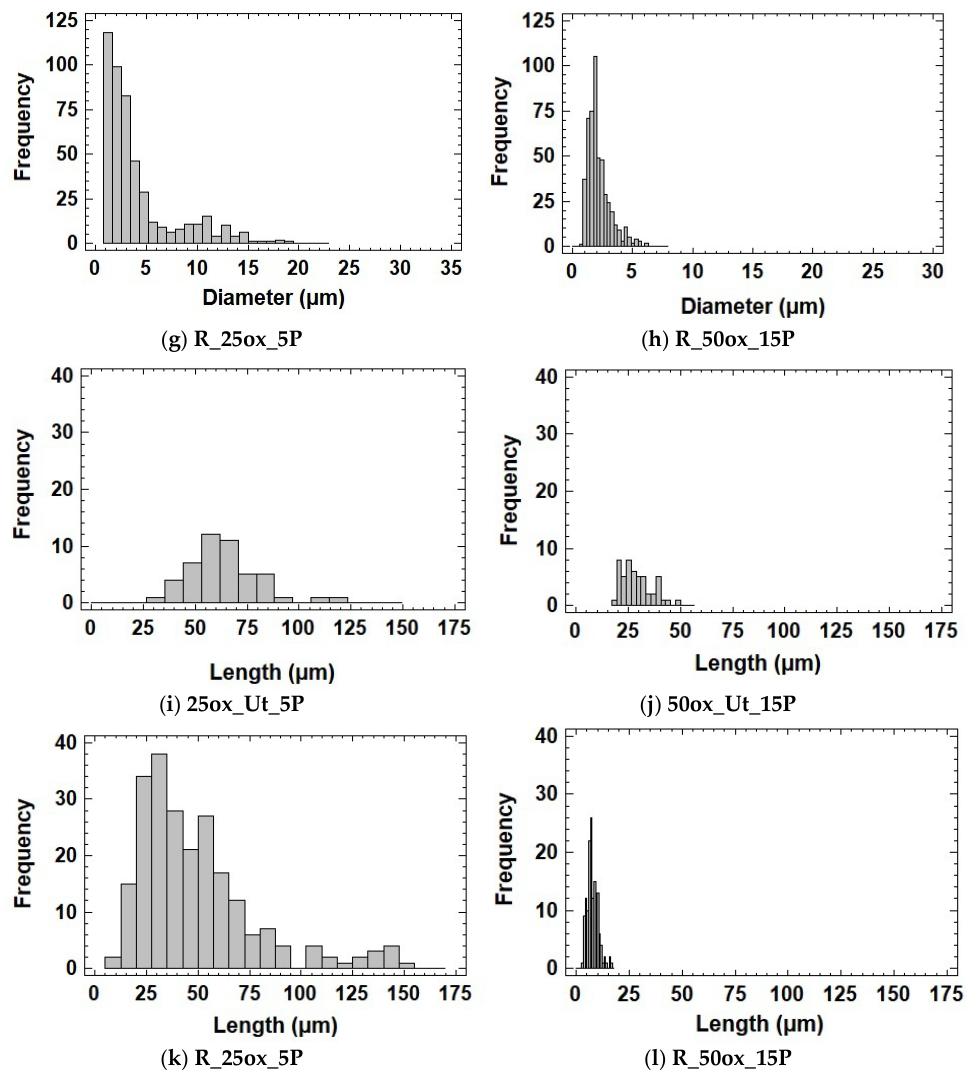
Figure 2. Optical microscopy images of ( a ) 25ox_Ut_5P, ( b ) 50ox_Ut_15P, ( c ) R_25ox_5P and ( d ) R_50ox_15P of CMNF. Distribution of diameter ( e – h ) and length ( i – l ) of samples fraction of a diameter greater than 1.0 µm. Table 4. Average diameter of CMF fraction determined by